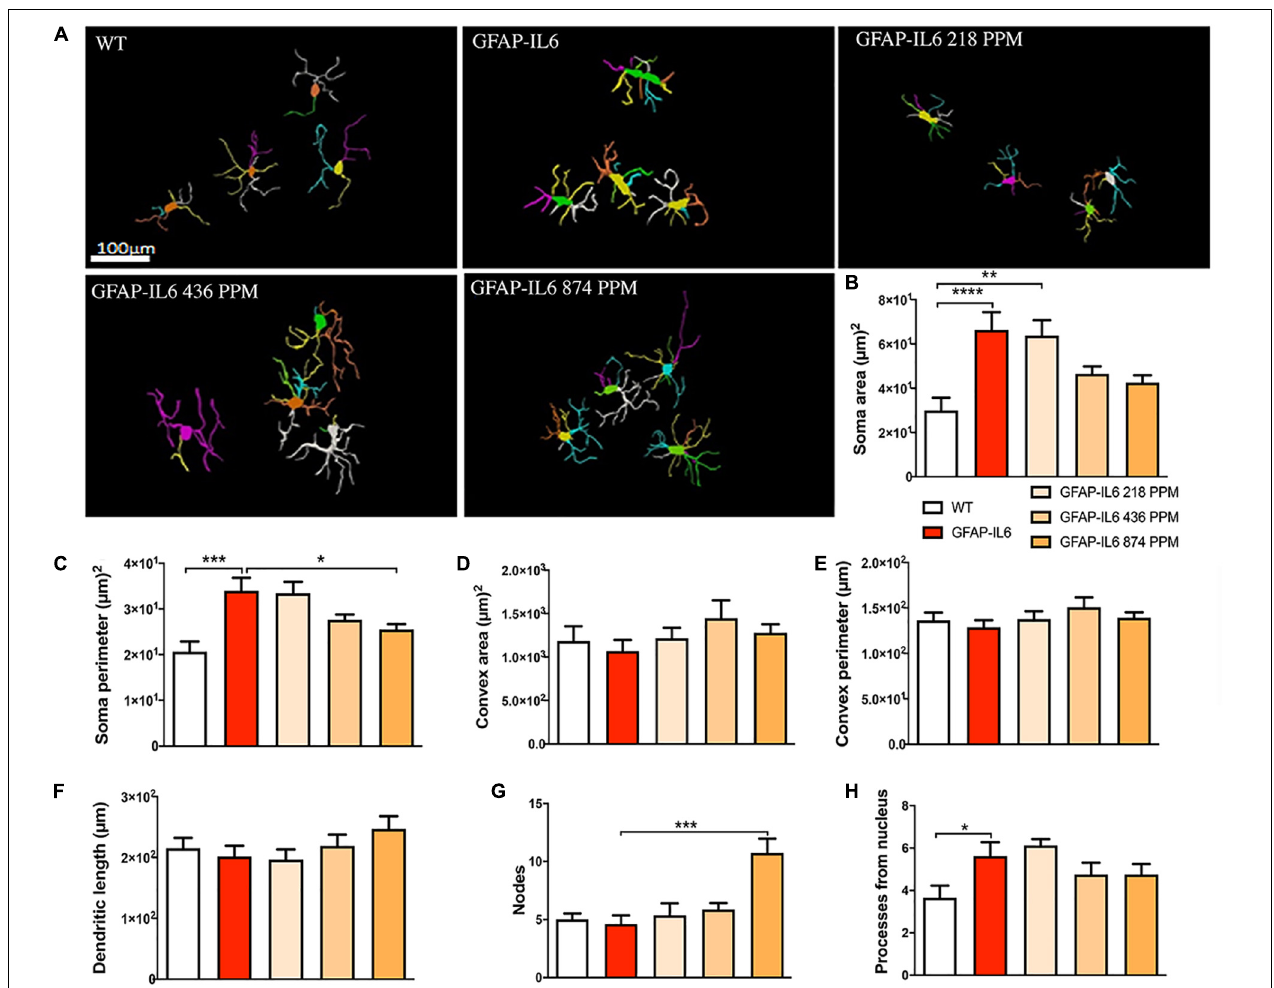
FIGURE 8 | Effect of MC on the morphological characteristics of microglial cells in the hippocampus. (A) Morphological assessment of reactive and non-reactive microglia in the hippocampus. (B–H) Microglia in the inflamed mice have significantly larger soma area, soma perimeter and processes compared with the WT mice. High dose MC significantly reduced soma area and soma perimeter compared with GFAP-IL6 mice. However, the same high dose MC significantly increased the number of nodes compared with the GFAP-Il6 mice. It has no effect on the convex area, convex perimeter, dendritic length and number of processes. Significance = * p < 0.05, ** p < 0.001, *** p < 0.0001, **** p <